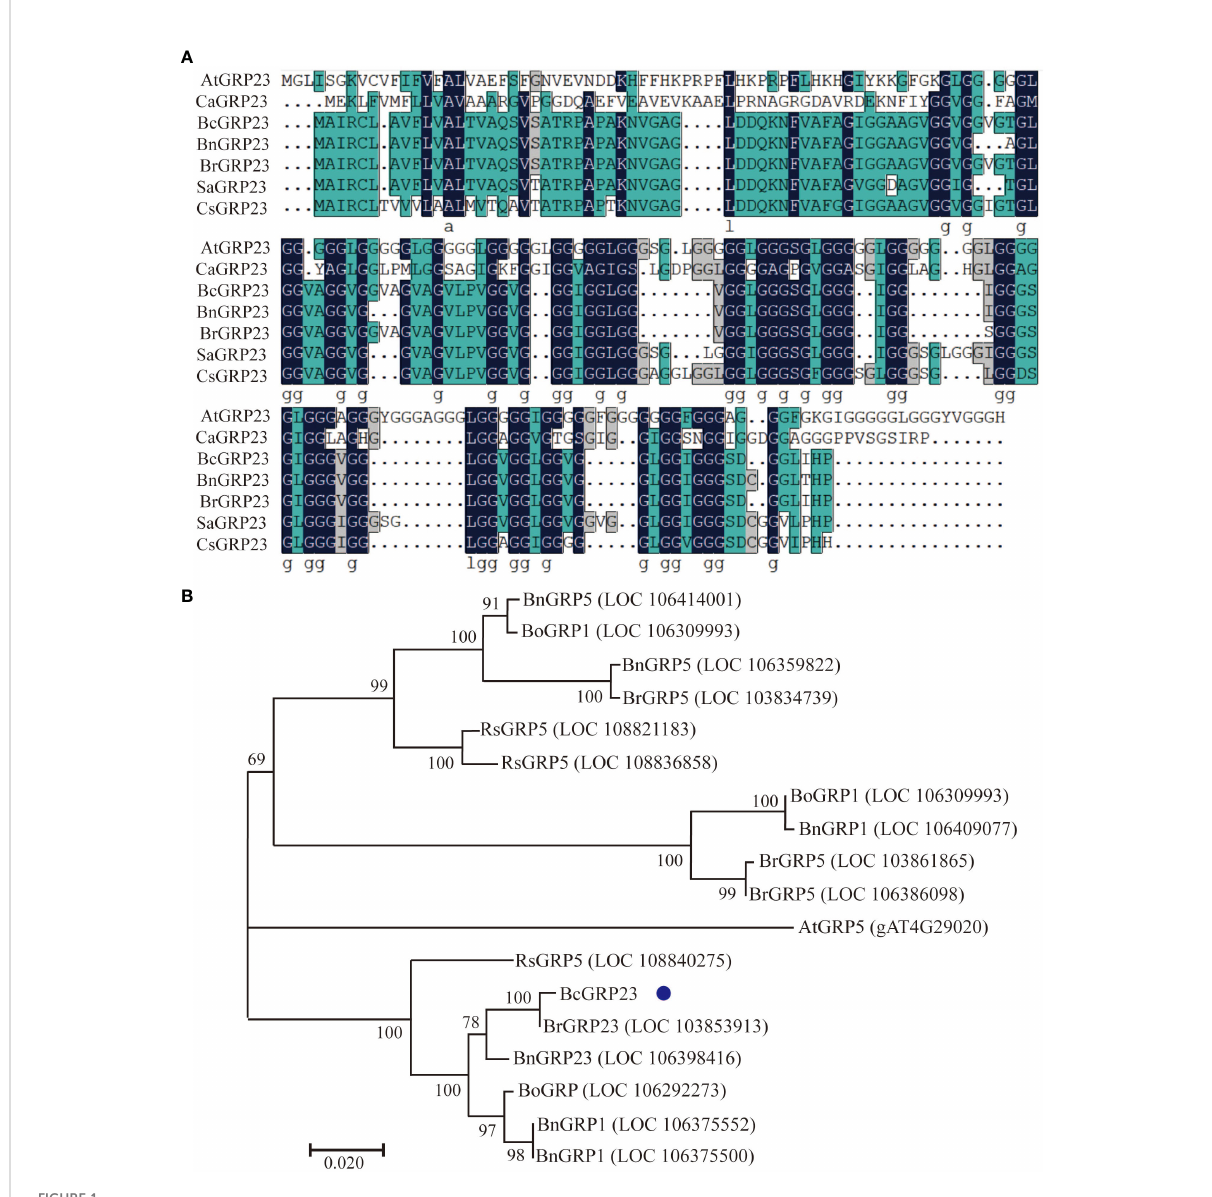
FIGURE 1 Protein sequence alignments of BcGRP23 in fl owering Chinese cabbage and other species. (A) Multiple sequence alignment performed using MEGA7 software. Amino acids with blue background are highly conserved. The sequences were markedly similar between Brassica rapa , Cucumis sativus , Brassica napa , Sinapis alba , Camelina sativa , and Arabidopsis thaliana . (B) Phylogenetic analysis of the glycine-rich protein (GRP) sequences of different plant species performed using the neighbor joining method in MEGA7, with 1,000 bootstrap replicates. Bo , B. oleracea ; Bn , B. napus ; Bc , B. campestris ; Rs , Raphanus sativus